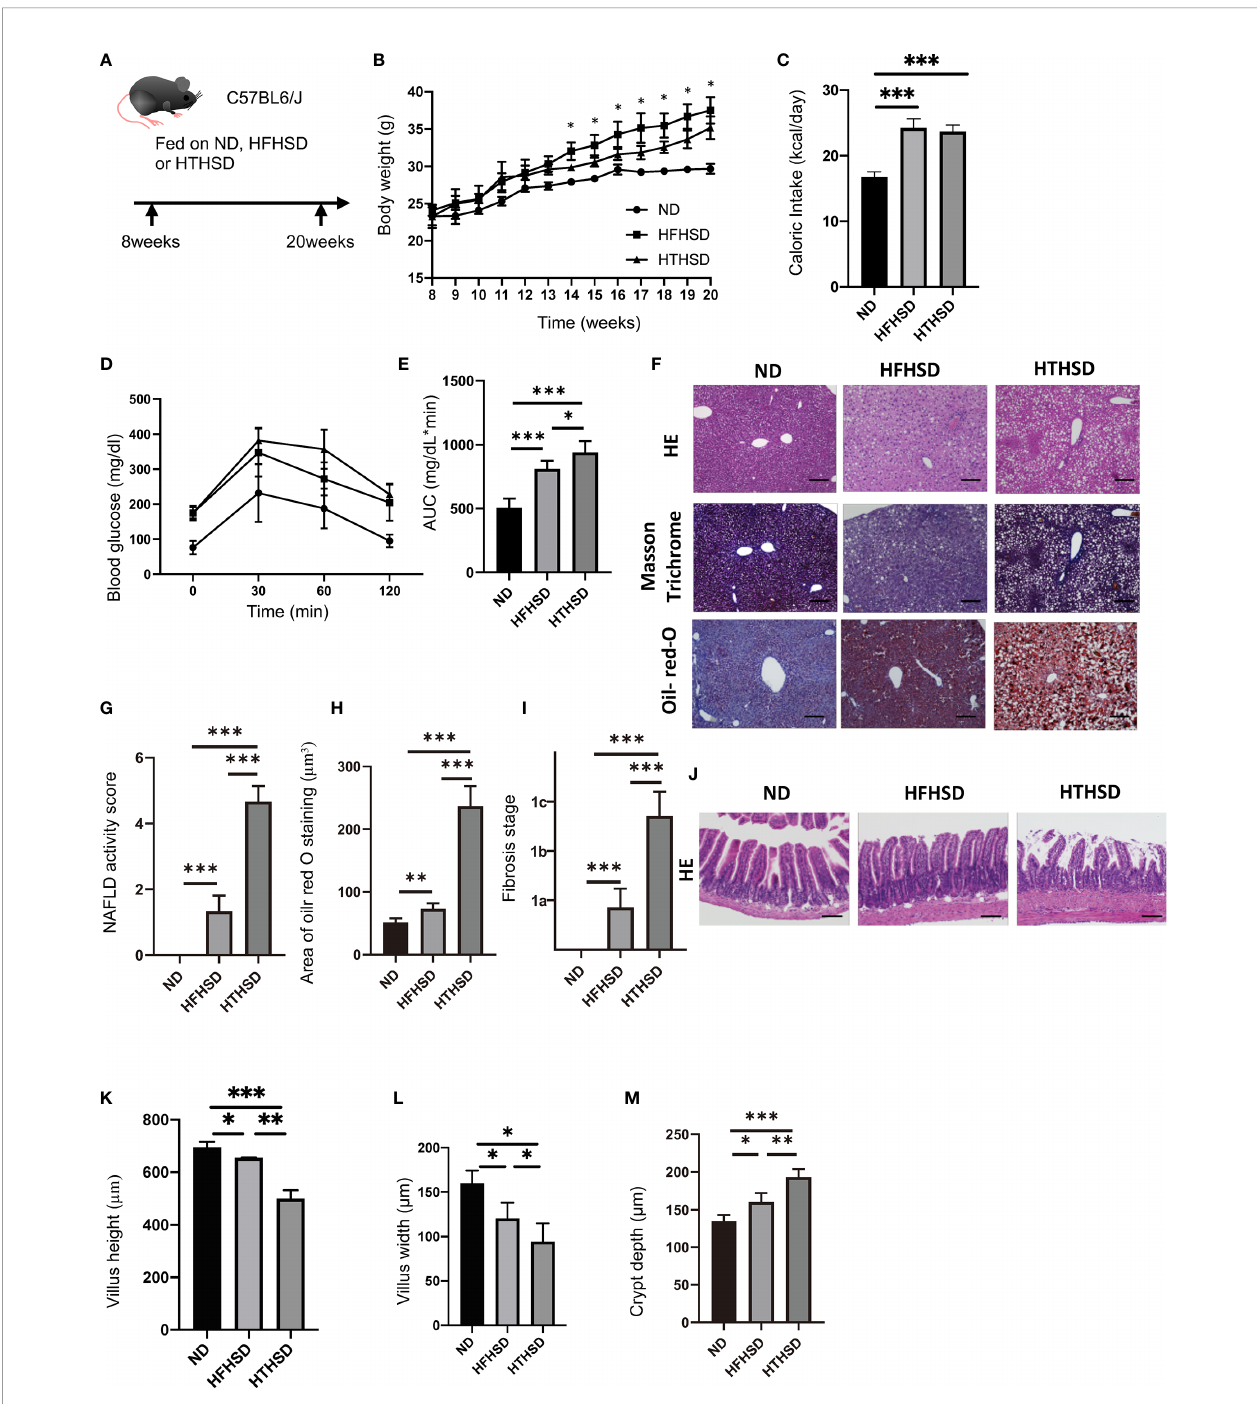
FIGURE 1 | Trans fatty acids signi fi cantly worsen glucose tolerance, despite causing only mild weight gain, as compared to saturated fatty acids. (A) Eight-week-old C57BL6/J mice were fed with ND, HFHSD, or HTHSD for 12 weeks, starting at 8 weeks of age. The mice were sacri fi ced when they reached 20 weeks of age. (B) Changes in the body weights of the mice (n=6). If the weight of mice fed with HFHSD was signi fi cantly higher than that with HTHSD by an unpaired, two-tailed Student ’ s t test, it was marked with asterisk on top. (C) Caloric intake measured at 20 weeks of age (n=6). (D, E) When the mice reached 20 weeks of age, an intraperitoneal glucose tolerance test (2 g/kg body weight) was performed, followed by analysis of the area under the curve (n=6). (F) Representative liver histology of the mice. (G) NAFLD activity score (n=6). (H) Oil Red O-stained area (n=6). (I) Fibrosis stage (n=6). (J) Representative jejunum histology of the mice. (K) Villus height (n=6). (L) Villus width (n=6). Data are represented as mean±SD; *p < 0.05, **p < 0.01, ***p < 0.001 using Tukey HSD test. ND, normal diet; HFHSD, high-fat, high- sucrose diet; HTHSD, high-trans fatty acid, high-sucrose diet. (M) Crypt depth